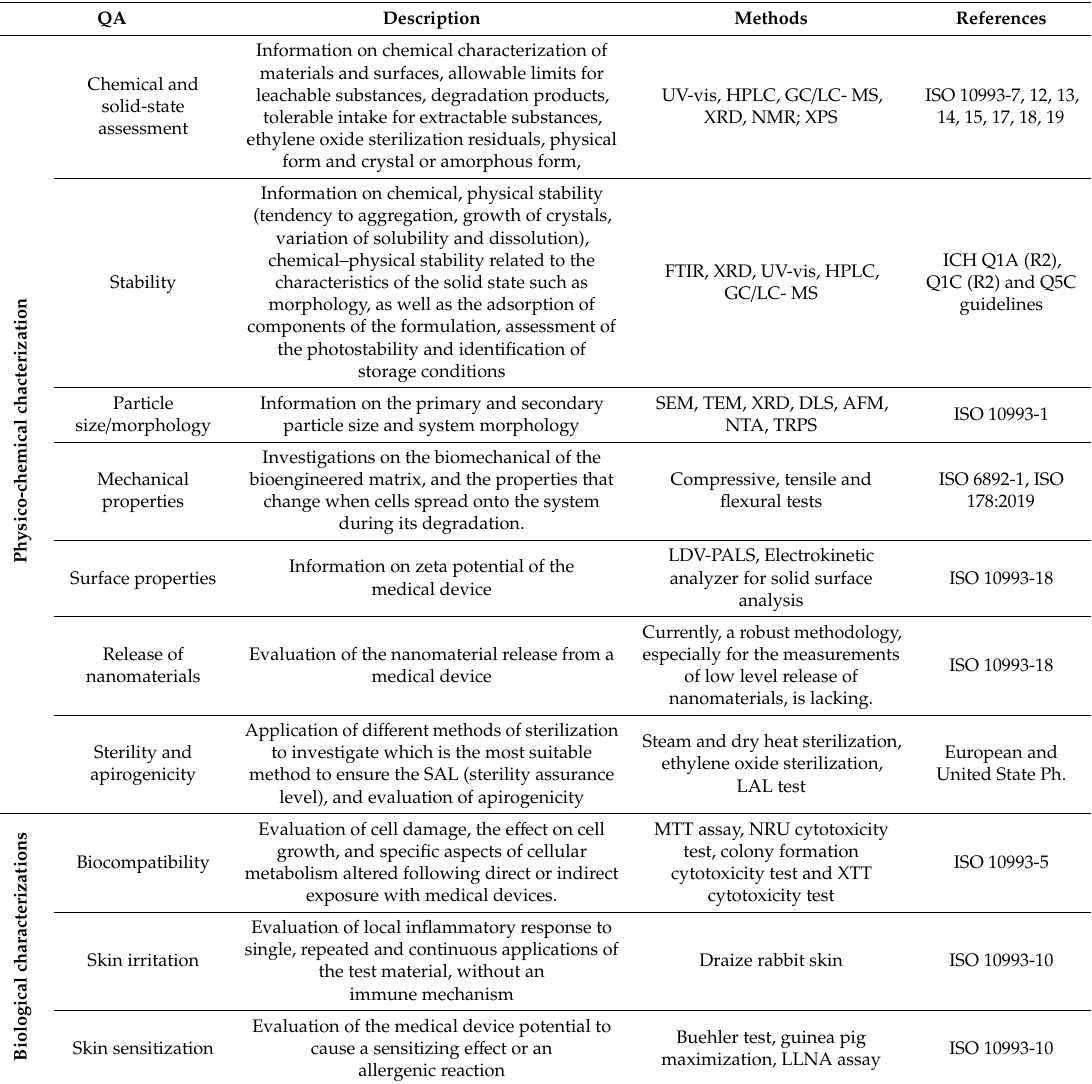
Table 3. Quality attributes (QA) for characterization of